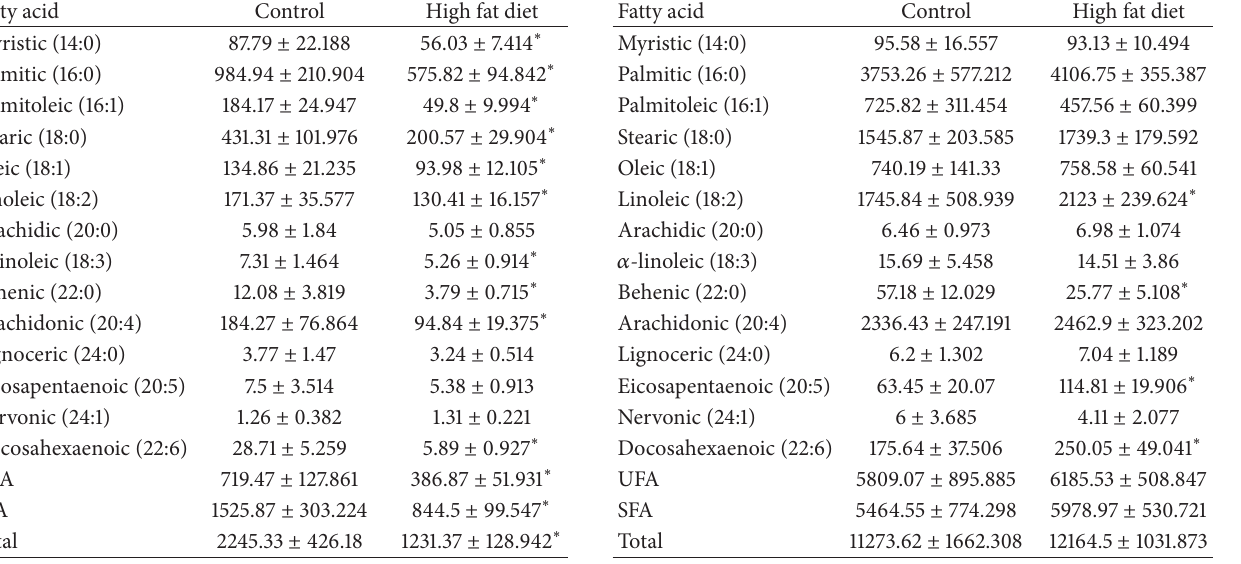
Table 8: Triacylglycerols composition in the parotid salivary glands (nmol/g). Fatty acid